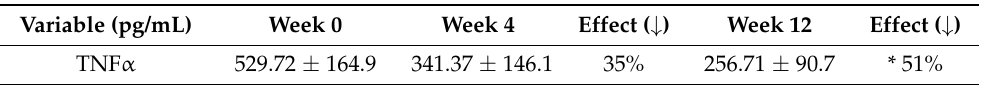
Table 10. Changes of TNF α level (pg/mL) during treatment ( n = 50). * indicates a statistically significant difference ( p < 0.05).